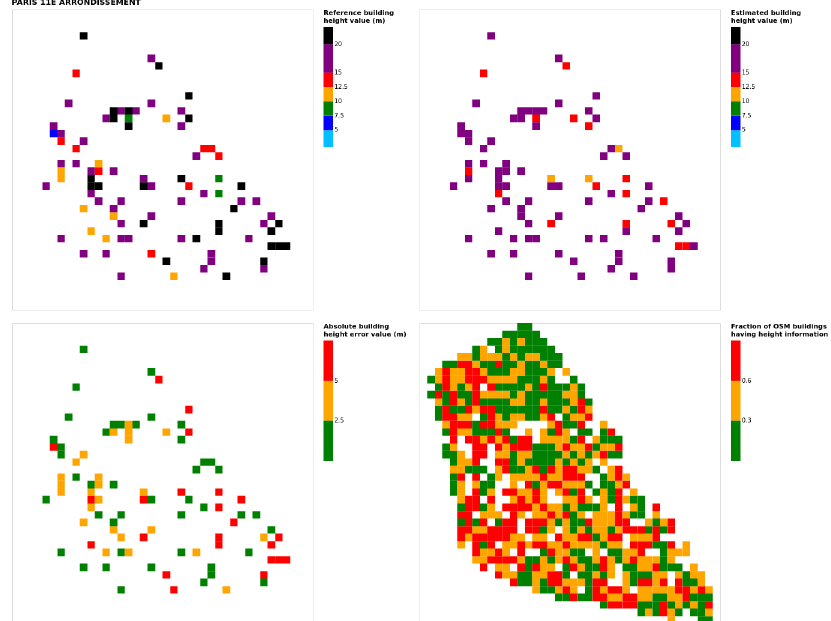
Figure B16. Results for the commune at grid cell (upper left panel) reference building height, (upper right panel) estimated building height, (lower left panel) absolute building height error, and (lower right panel) fraction of OSM buildings that have height information. For all panels except the lower right, only cells that have buildings – with at least 90% of their buildings having no height value in OSM – are